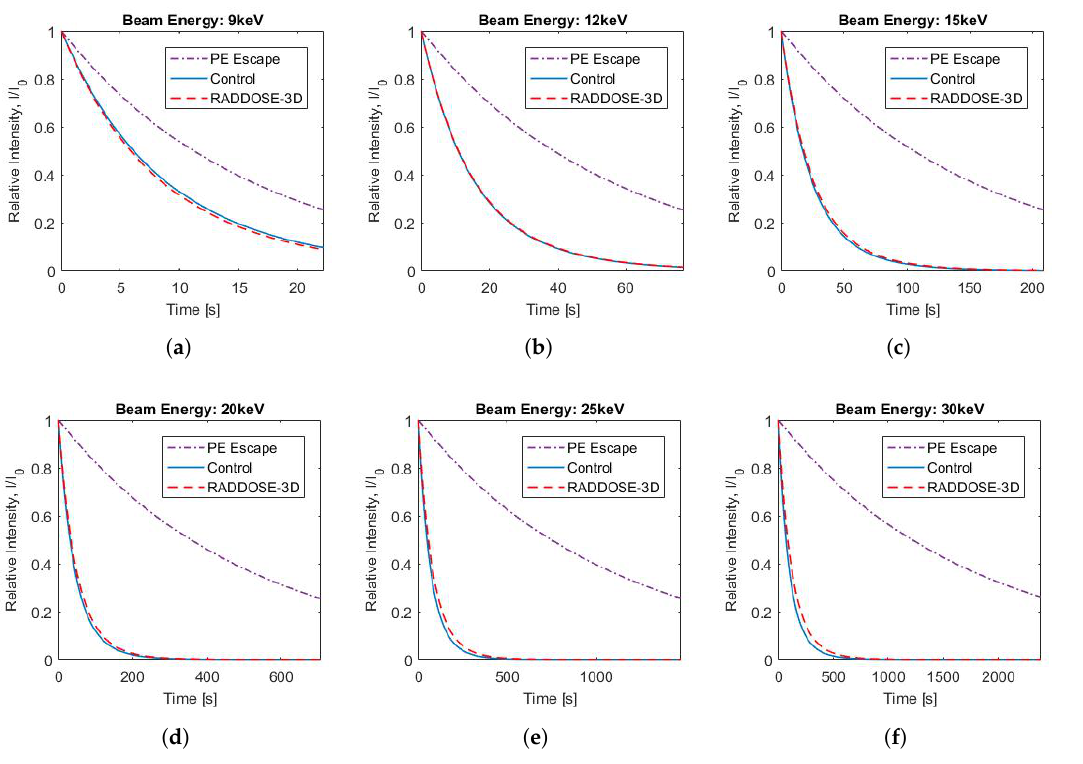
Figure 3. Relative intensity, I / I 0 , as a function of time, for a 3Å Bragg spot generated by a 1µm crystal centred in a 1µm beam with an incident flux of 1 × 10 10 photonss −1 and beam energy of: ( a ) 9keV; ( b ) 12keV; ( c ) 15keV; ( d ) 20keV; ( e ) 25keV; and ( f ) 30keV. Three sets of dose maps were used in the simulations: Purple dot-dash lines and solid blue lines show results based on our simulated dose maps (see Section 4.5). The former accounted for PE escape, the latter (control) did not; both accounted for Compton scattering. Dashed red lines show results based on RADDOSE-3D [9] dose maps; the version used did not account for either PE escape or Compton scattering. Incorporating PE escape resulted in lower damage rates being predicted at all energies, with increasing discrepancy seen between results as the energy increased from 9keV to 20keV, and minimal change in discrepancy observed above 20keV. Inclusion of Compton scattering did not result in any significant discrepancy between the two simulations that ignored PE escape for energies up to 20keV and resulted in only a small deviation at 25keV and